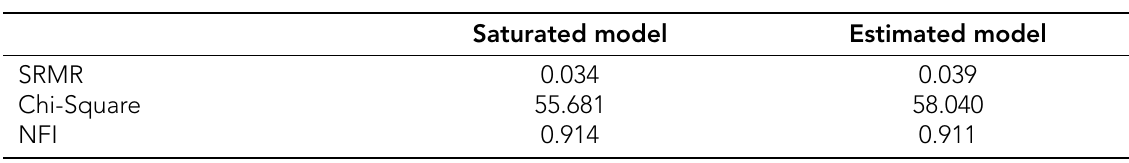
Table 6. Model fit indices (Source: Authors,